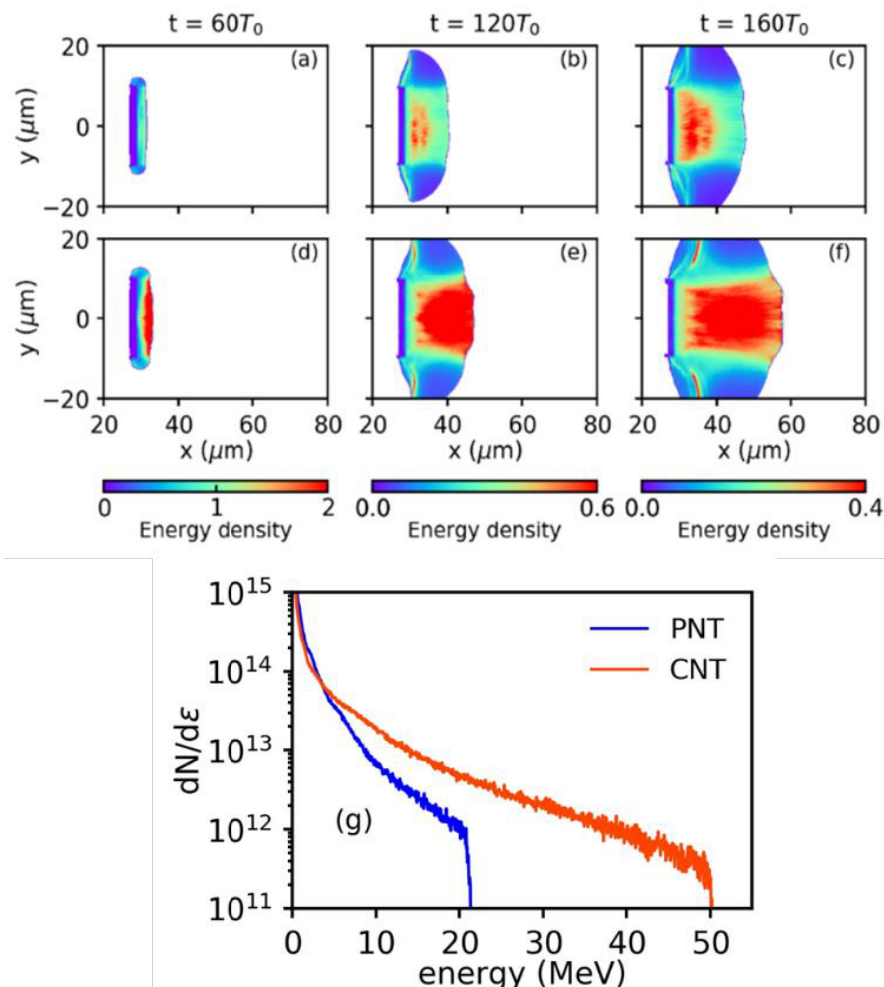
Figure 4. ( a – f ) Temporal evolution of energy density (normalized by n c m p c 2 ) at different times for the PNT ( a – c ) and the CNT ( d – f , g ) energy spectra of protons at the end of simulation.